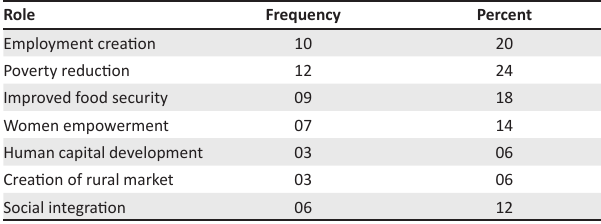
TABLE 3: Roles of cooperatives in improving livelihoods.